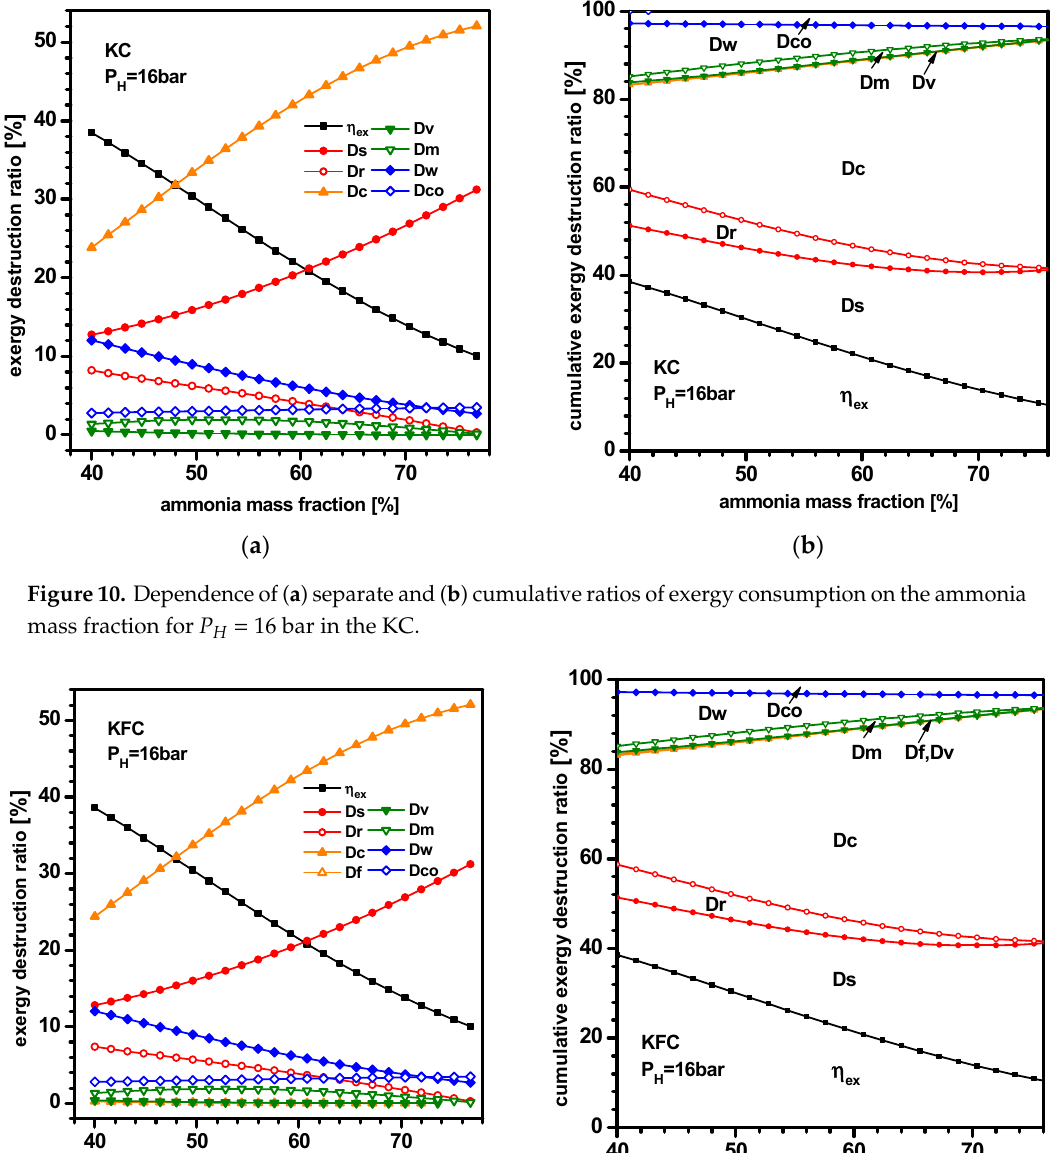
( b ) Figure 12. Dependence of ( a ) separate and ( b ) cumulative ratios of exergy consumption on the ammonia mass fraction for P H = 48 bar in the KC.